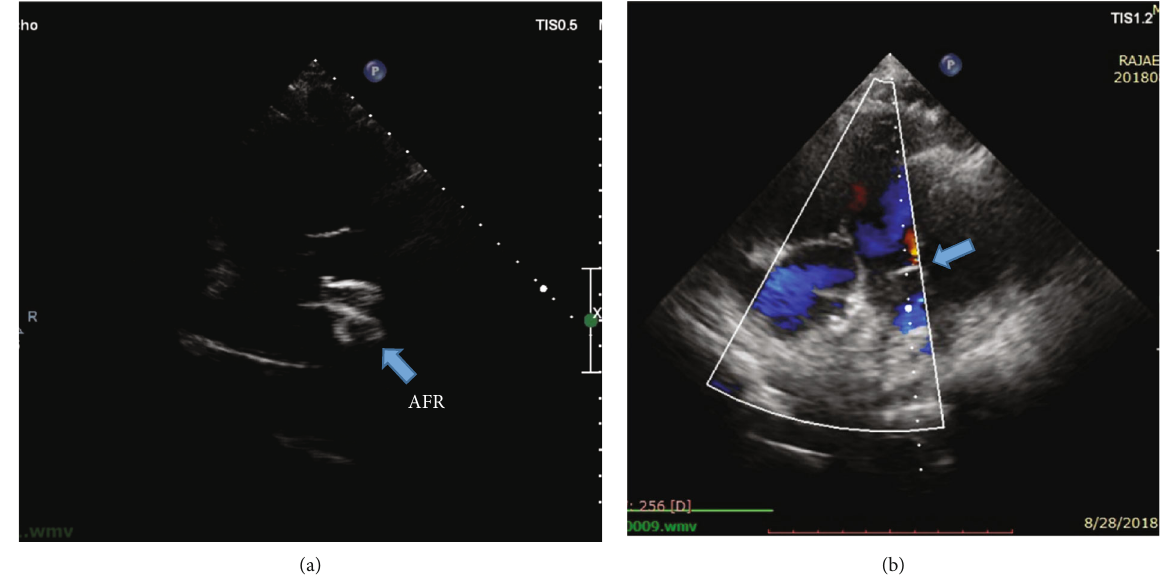
Figure 4: Follow-up echocardiography indicating the proper position of the AFR device with left-to-right